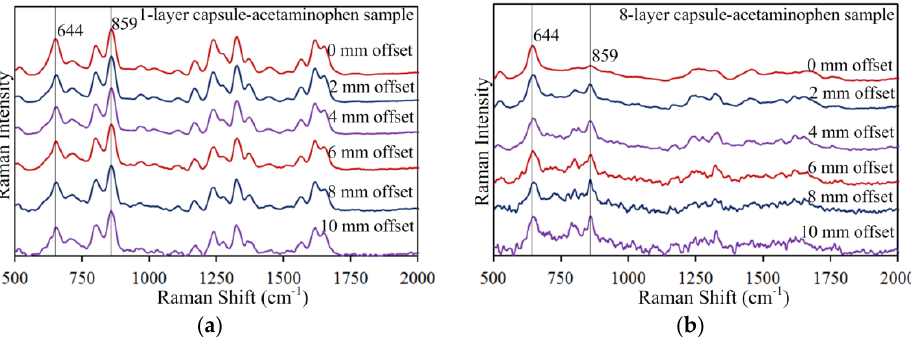
Figure 7. Spatially offset Raman spectra of ( a ) one-layer and ( b ) eight-layer capsule-acetaminophen samples.